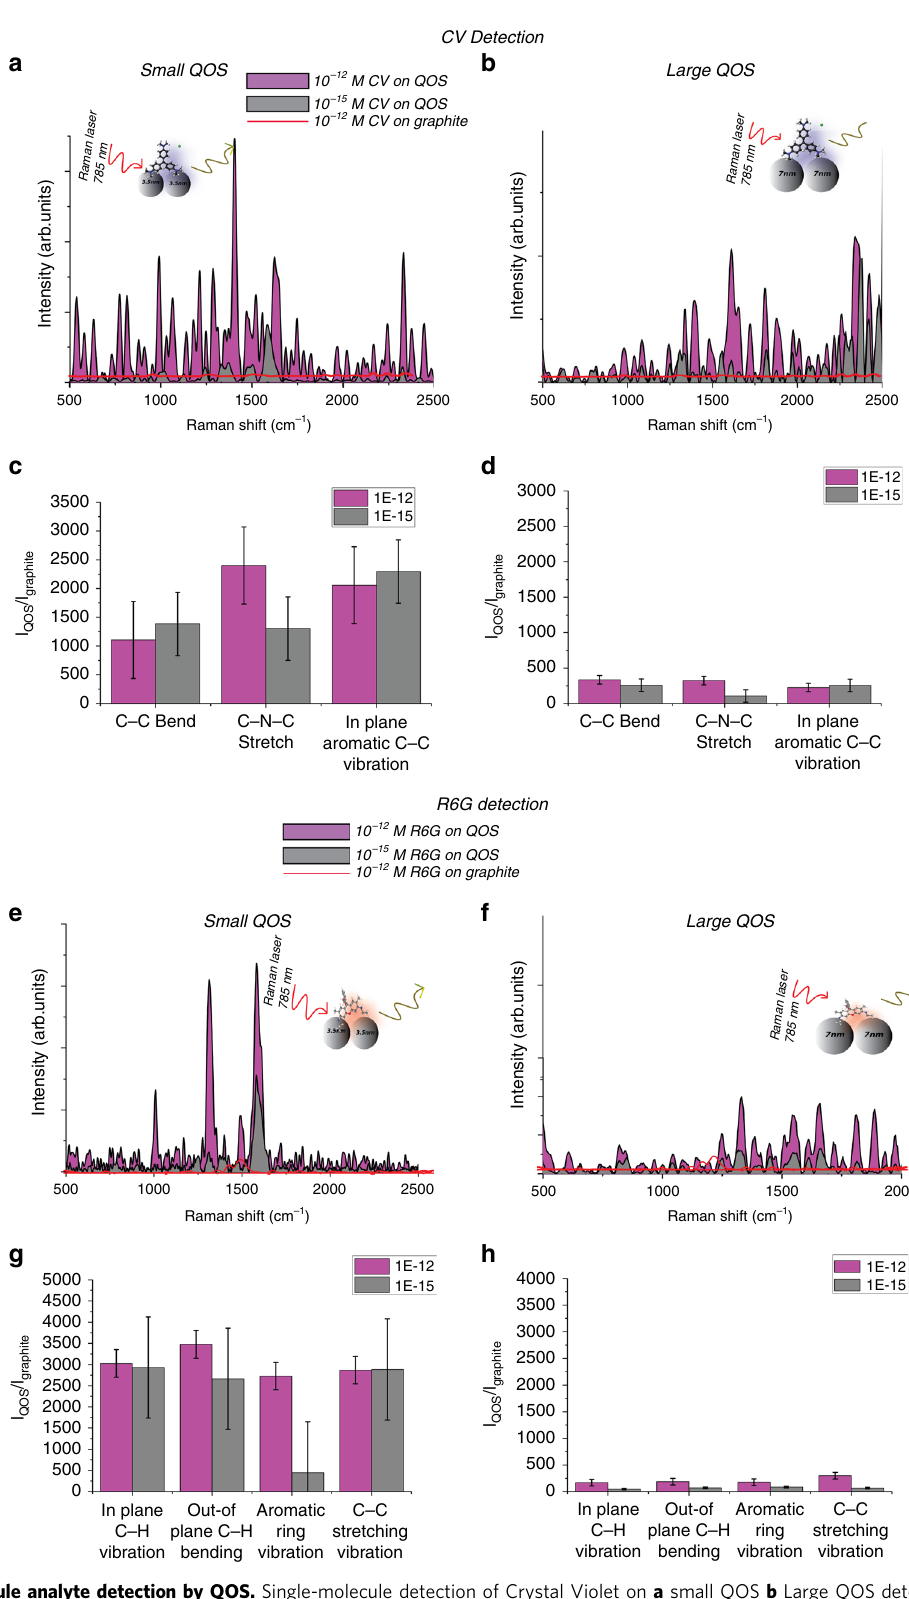
Fig. 2 Single-molecule analyte detection by QOS. Single-molecule detection of Crystal Violet on a small QOS b Large QOS detection of CV. c , d Enhancement ef fi ciency of molecular bonds of as a function of I QOS / I graphite on small QOS and large QOS, respectively. Single-molecule detection of R6G with e small QOS and with f large QOS. g , h Enhancement ef fi ciency of molecular bonds of as a function of I QOS / I graphite on small QOS and large QOS,